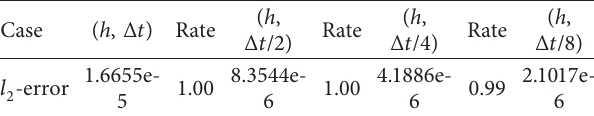
Table 9: Convergence test results of the unconditionally stable method for time step.